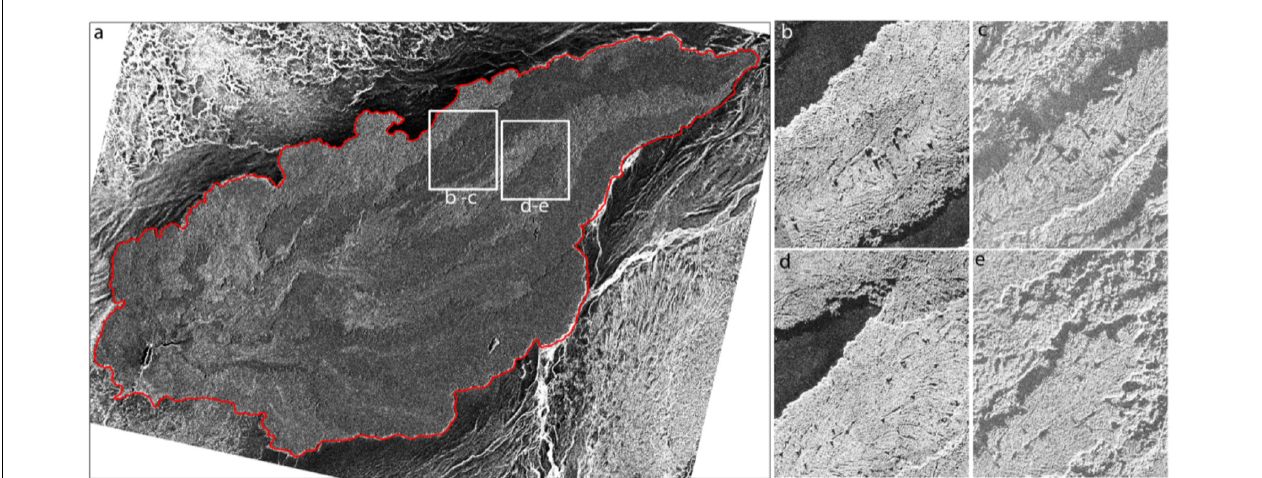
FIGURE 12 | (a) TSX SAR amplitude image of the entire lava field from January 16, 2015. The red outline show the mapped boundaries of the lava field. Internal morphologies can be observed but details cannot be resolved. The gray boxes show zoom in on lava flow 1 and 2. (b) Aerial SAR image of a part of lava flow 1 on November 8, 2014 before tube formation. (c) Aerial SAR image of a part of lava flow 1 on April 24, 2015 after tube formed lifting up the central part of the lava channel. (d) Aerial SAR image of a part of lava flow 2 on November 8, 2014 before tube formation. (e) Aerial SAR image of a part of lava flow 2 on April 24, 2015 after tube formed lifting up the central part of the lava channel and resurfacing the surroundings. Tube inflation is typically revealed by shadows in the SAR amplitude image that appear along the tube edge located away from the SAR sensor illumination (c,e) .